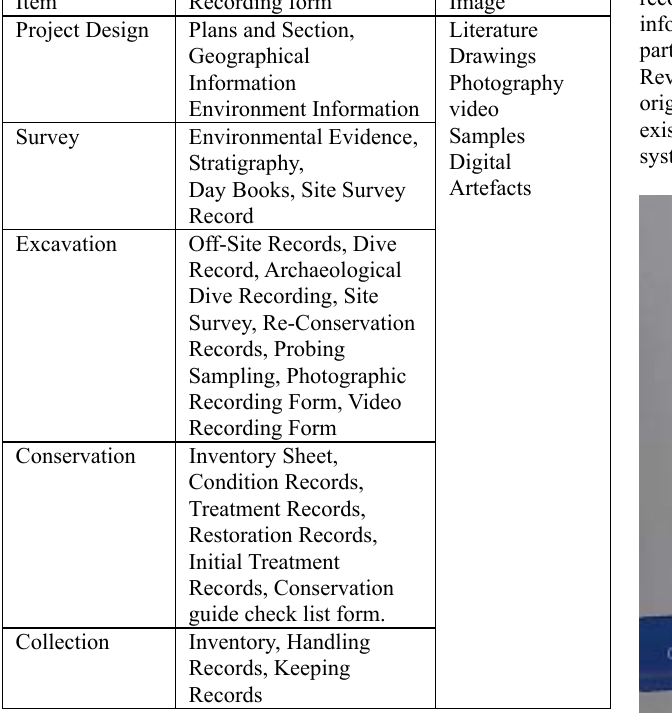
Figure 3. underwater archaeology work procedure